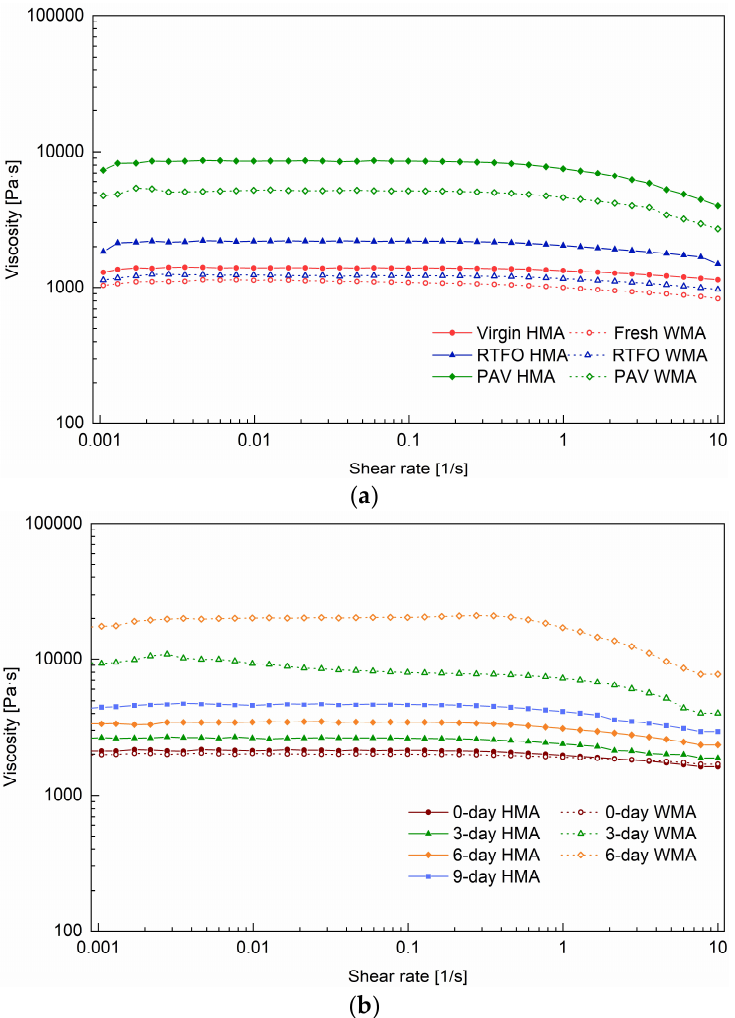
Figure 4. Shear rate dependency of viscosity of the binders at 60 ◦ C before and after ageing: ( a ) for groups 1, 2, and ( b ) for groups 3 and